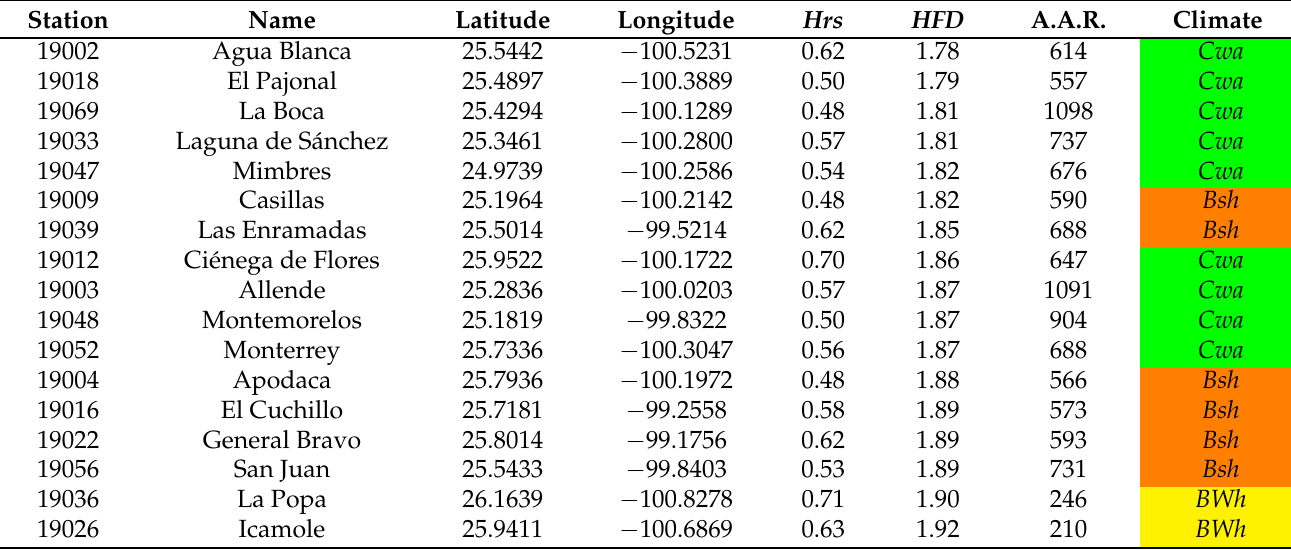
Table 1. Characteristics and results for the 17 stations analyzed. Climate is shown by the corresponding color taken from the CONABIO’s clustering that uses the Köppen climate classification, see Figure 1. Rows follow an ascending order with respect to the value of HFD